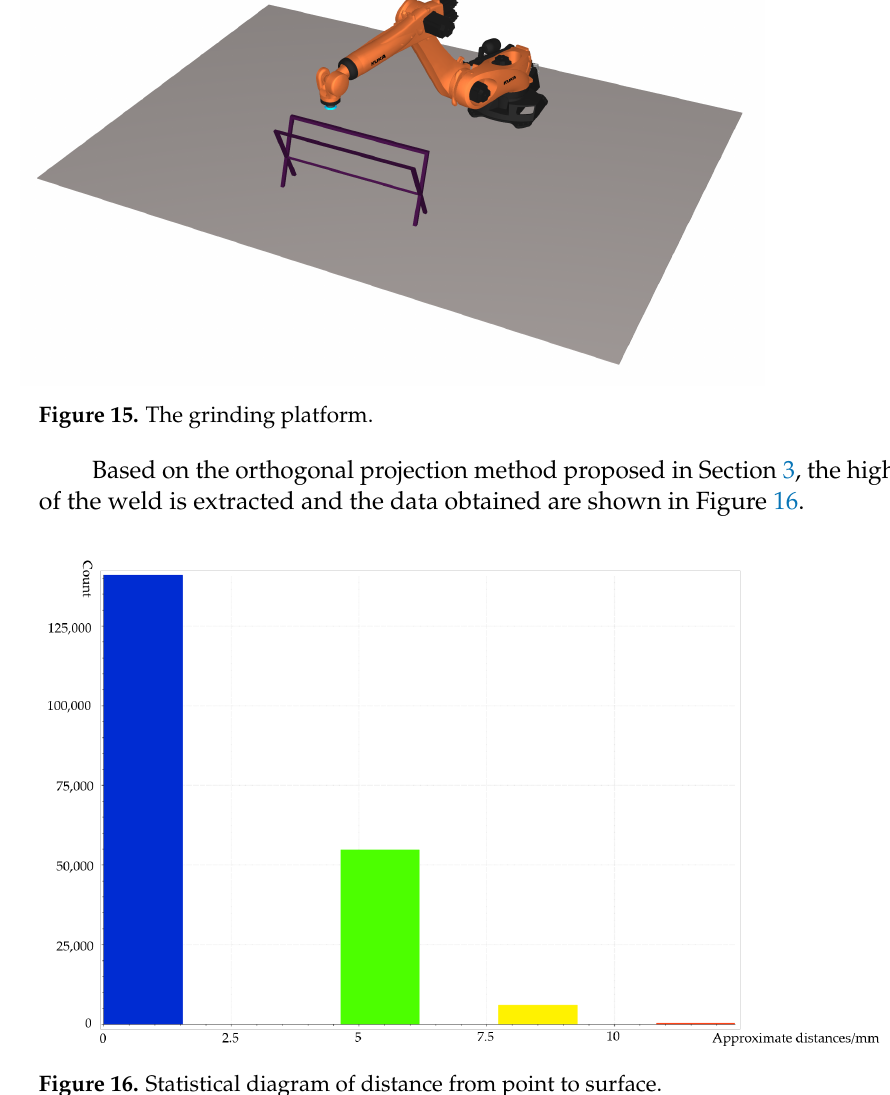
Figure 16. Statistical diagram of distance from point to